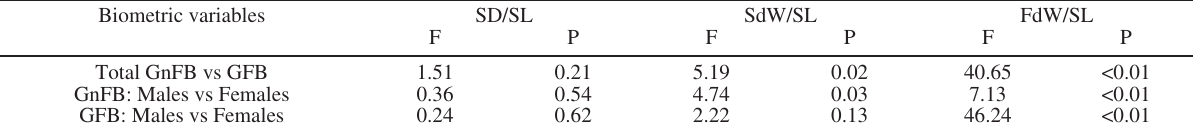
Table 4. – Results of the ANCOVA performed with data on relative growth of S. haemastoma . SL, shell length; SD, shell diameter; SdW, Shell dry weight; FdW, Flesh dry weight: GFB, gastropods fouled by barnacles; GnFB, gastropods non-fouled by barnacles. Biometric